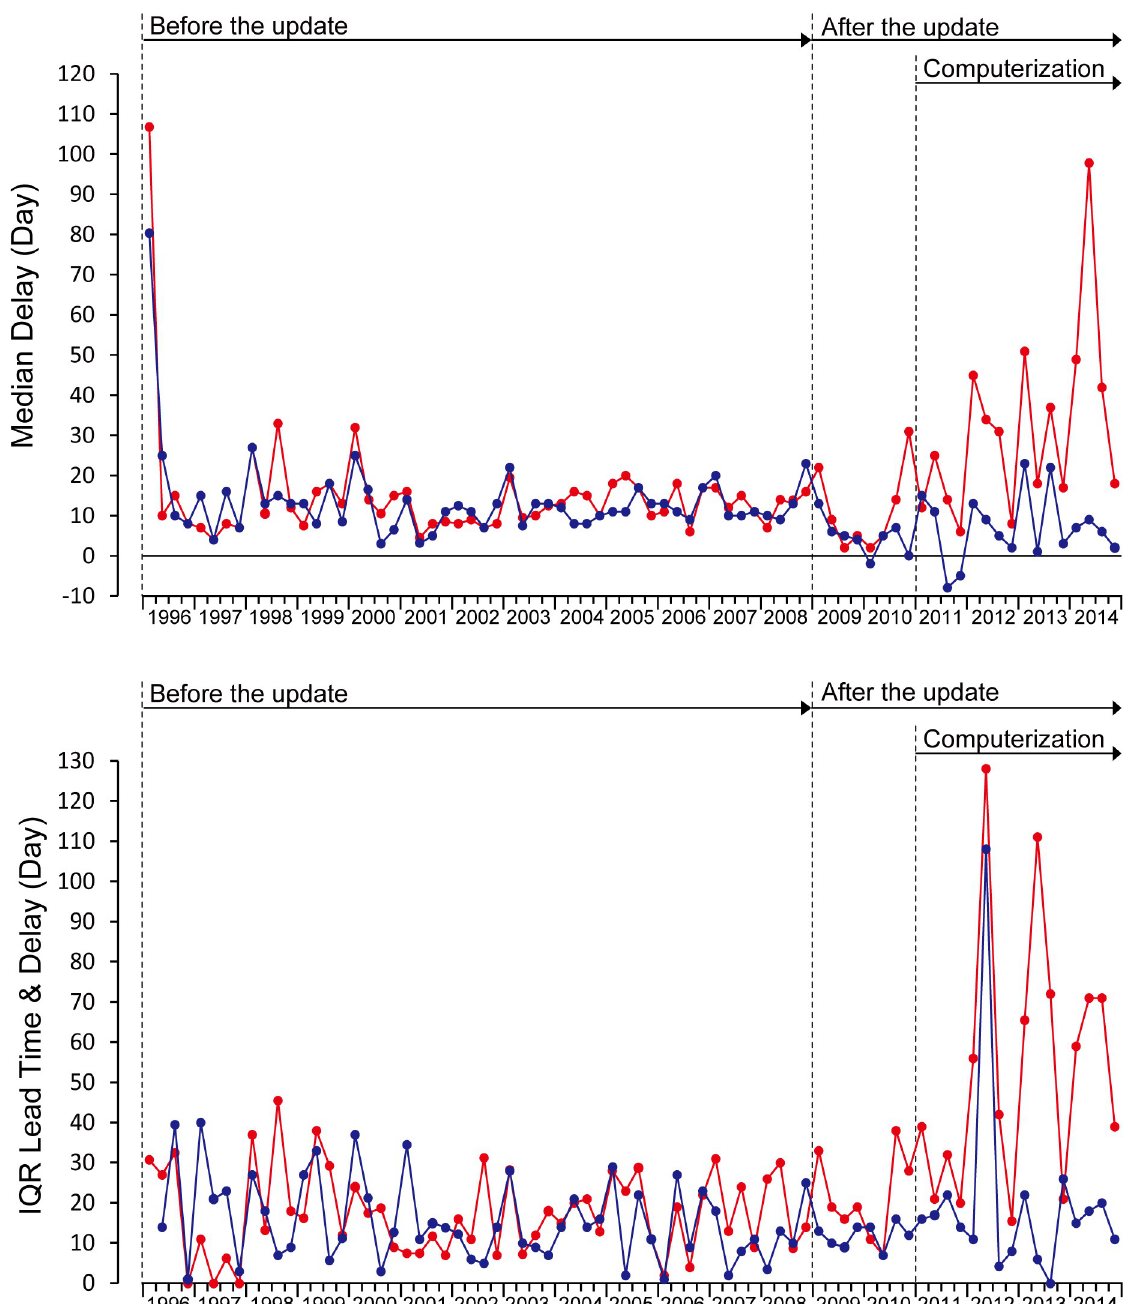
Fig 4. Changes in quarterly median delay and quarterly IQR in computerized data processing (Type 1) and manual data processing (Type 2). Redline: 15 health centers with computerized data processing (Type 1). Blueline: seven health centers with manual data processing (Type